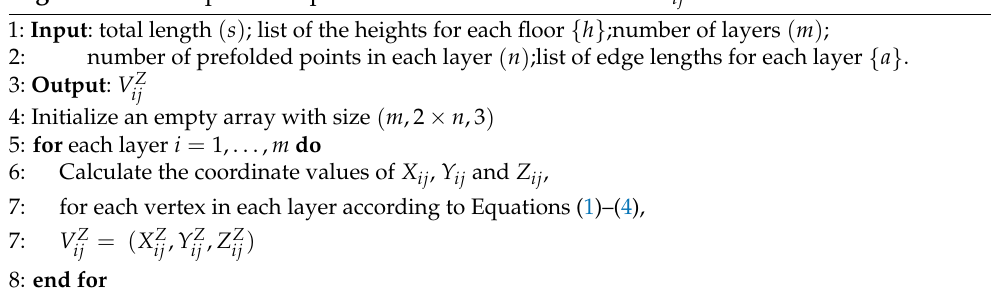
Algorithm 1 Compute 3D spatial coordinates of the vertex V ij